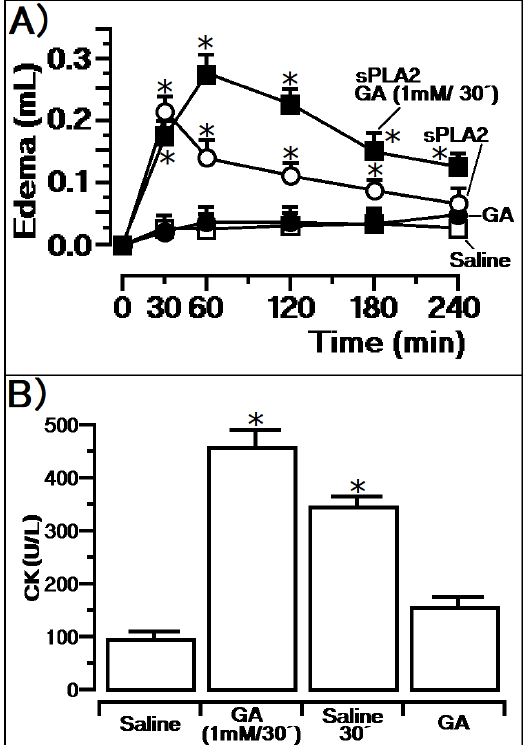
Figure 1. Evaluation of the GA previous treatment on the edema and myotoxicity triggered by sPLA2 from Cdt. In ( A ), the effect of the previous injection of GA, revealing an edema peak at 60 min, which is higher than the positive control (sPLA2) (n = 5, and * p < 0.05). In ( B ), myotoxic effect results of the animal treated previously with GA(GA (1 mM/30´) reveals a raise in the CK values when compared with the positive and negative controls (n = 5, and * p < 0.05).